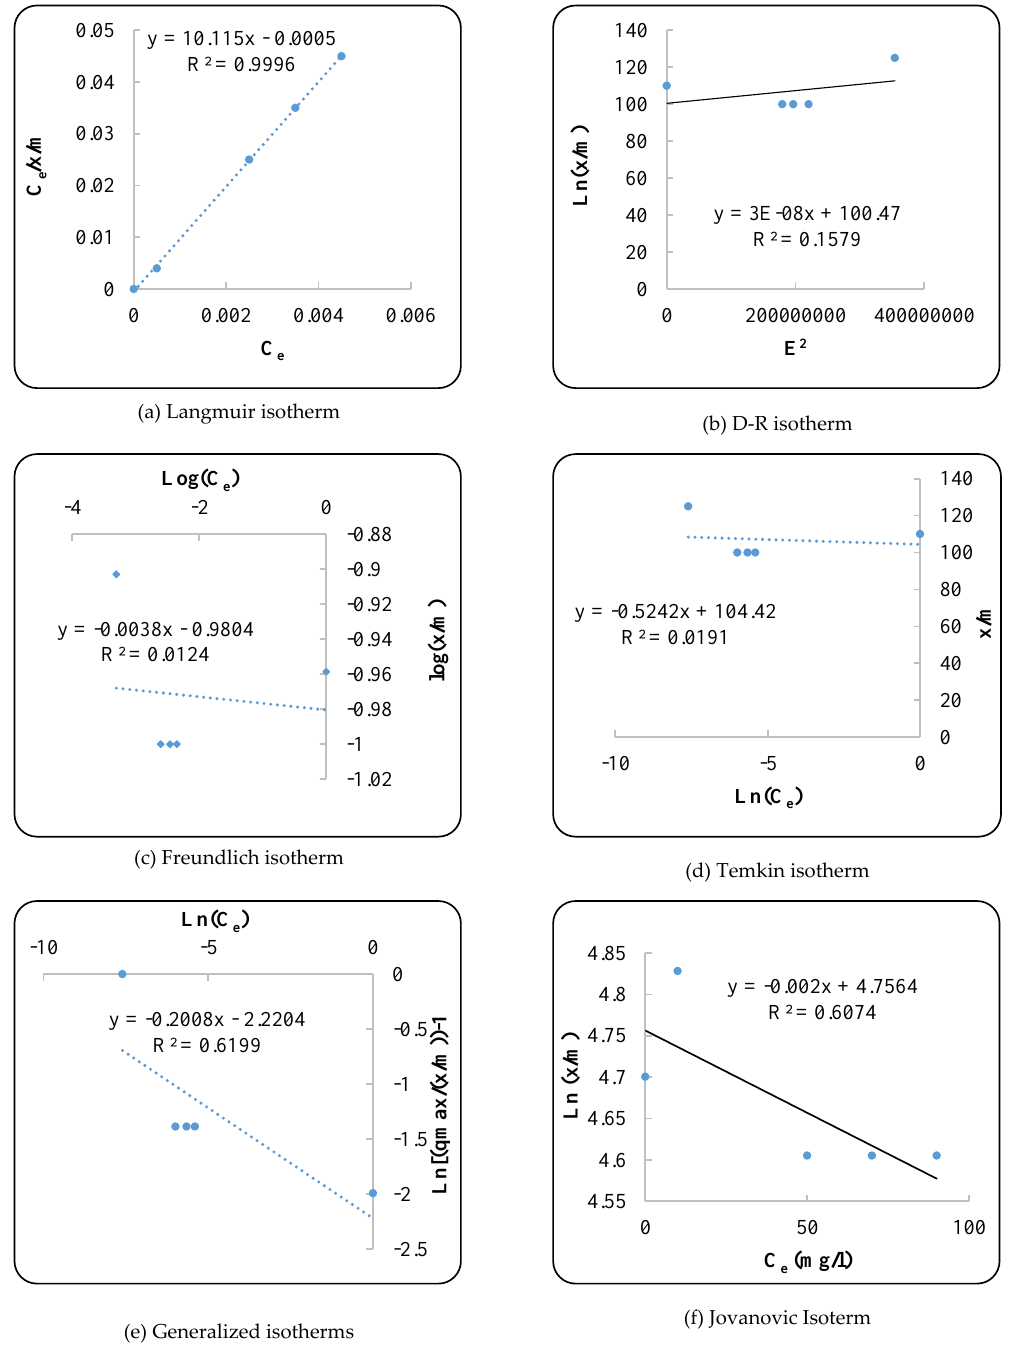
Figure 4. ( a – f ) The regression of Langmuir, D-R, Freundlich, Temkin, Generalized, and Jovian isotherms Figure 4. (a-f) The regression of Langmuir, D-R, Freundlich, Temkin, Generalized, and Jovian for removal of antibiotic from synthetic isotherms for removal of antibiotic from synthetic ASCA.